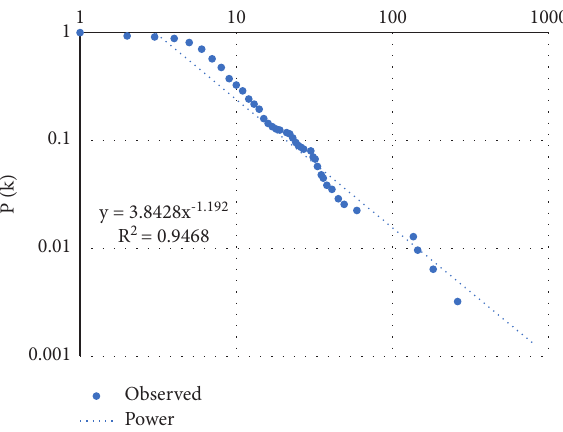
Figure 5: Cumulative degree distribution of the